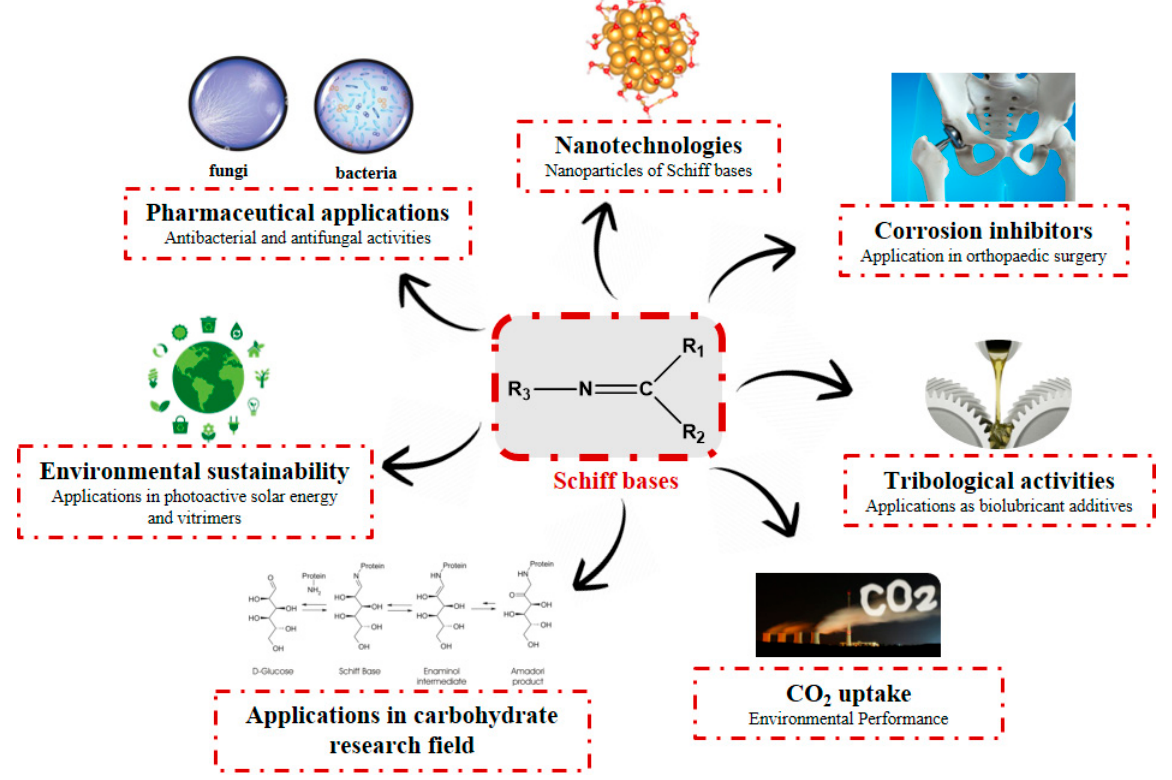
Figure 1. Main properties and uses of Schiff bases.